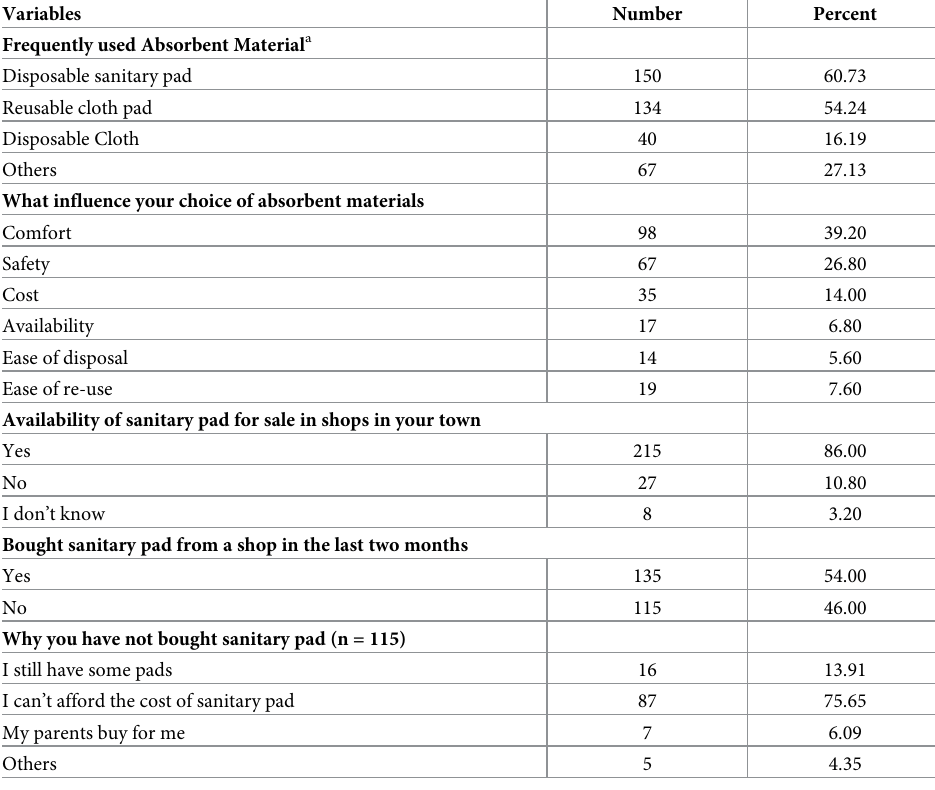
Table 4. Adolescent schoolgirls access to menstrual absorbent materials (n =